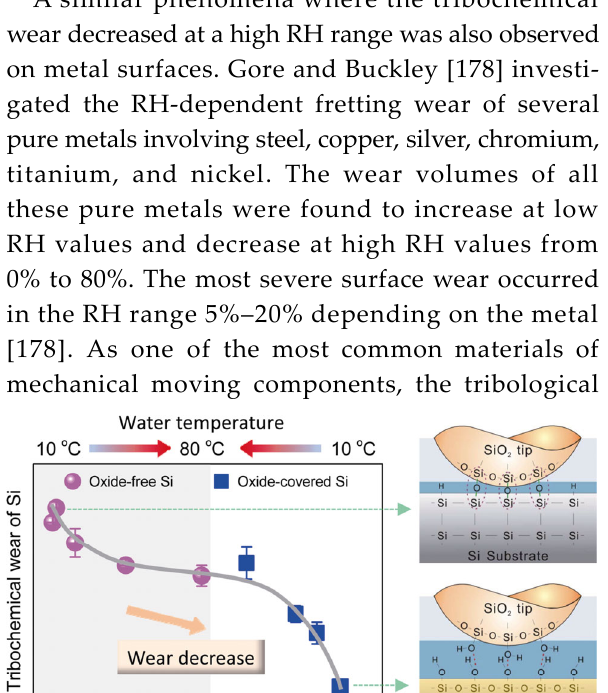
∣ www.Springer.com/journal/40544 | Friction http://friction.tsinghuajournals.com